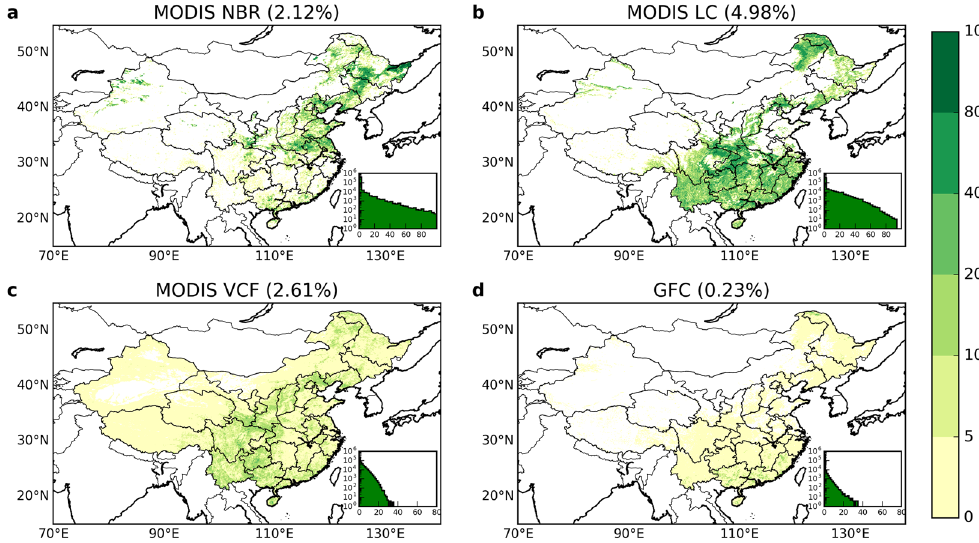
Figure 3. Spatial pattern of forest gain in China between 2000 and 2013 from different satellite datasets. These patterns were computed from similar (but not identical) time periods: ( a ) MODIS NBR for 2000–2013, ( b ) MODIS LC for 2001–2012, ( c ) MODIS VCF for 2000–2013, ( d ) Landsat GFC for 2000–2012. The total forest gain area was 207,639 km 2 in MODIS NBR, 478,040 km 2 in MODIS LC, 250,919 km 2 in MODIS VCF, and 22,405 km 2 in GFC. The other attributes of these panels were the same as for Fig. 1 but for forest gain. Maps were created using Python 2.7.11